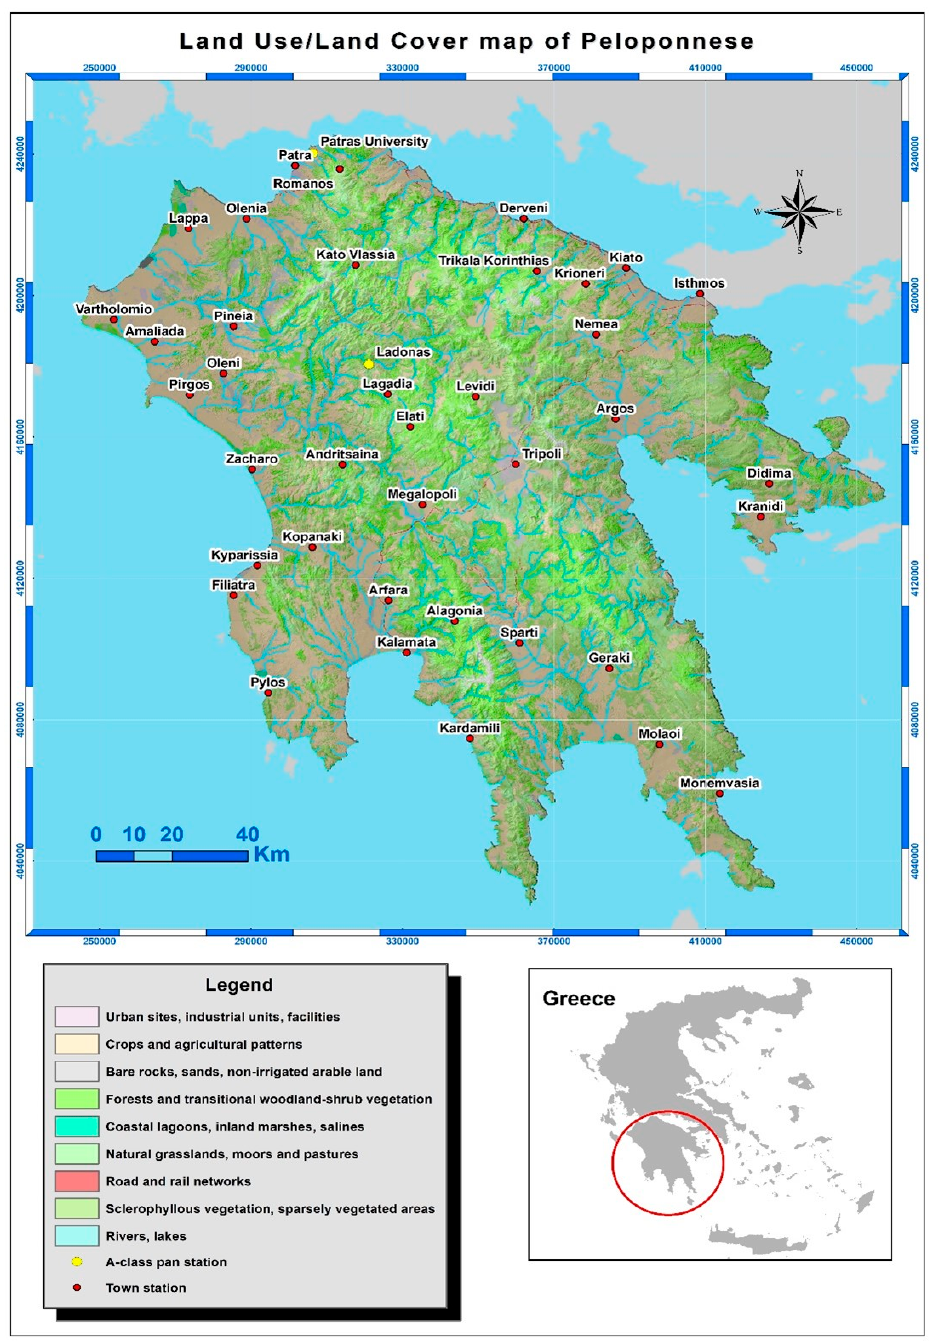
Figure 1. Land use/land cover map of the Peloponnese (Adapted with permission from ref. [62]. 2018, © European Union).